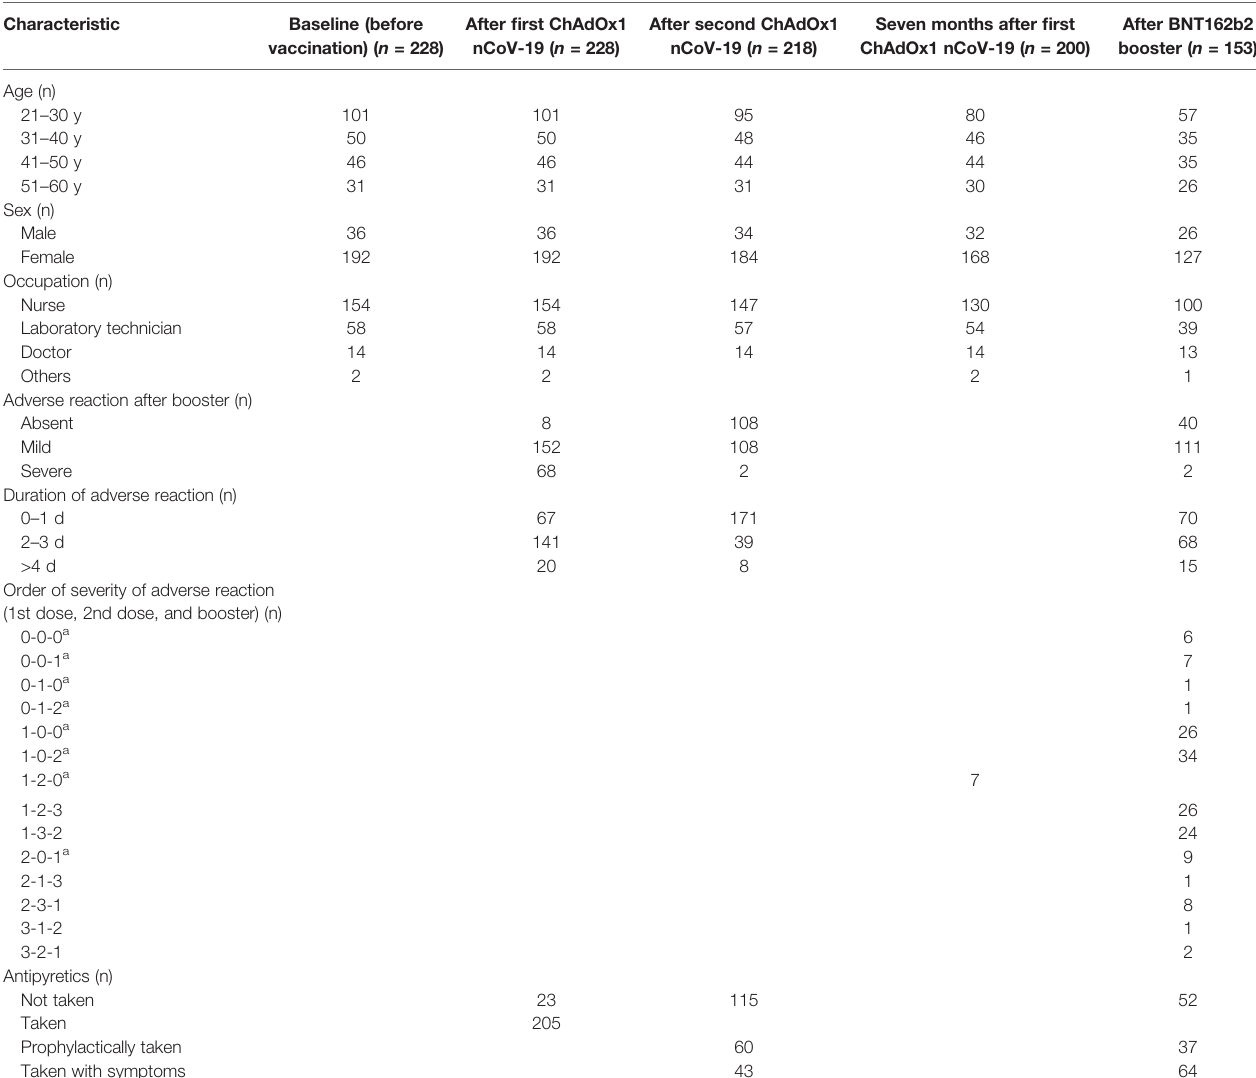
TABLE 1 | Basic characteristics of and adverse reactions after vaccination in participants in this longitudinal study over a 10-month period.